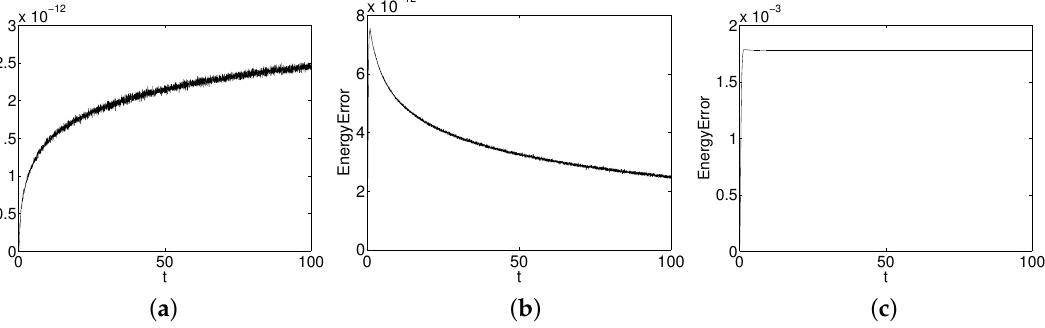
Figure 2. The double solitary wave’s energy error of second order AVF method, fourth order composition method and second order Preissman method in t ∈ [ 0,100 ] with τ = 0.02, h = 0.4. ( a ) AVF method; ( b ) composition method; and ( c ) Preissman